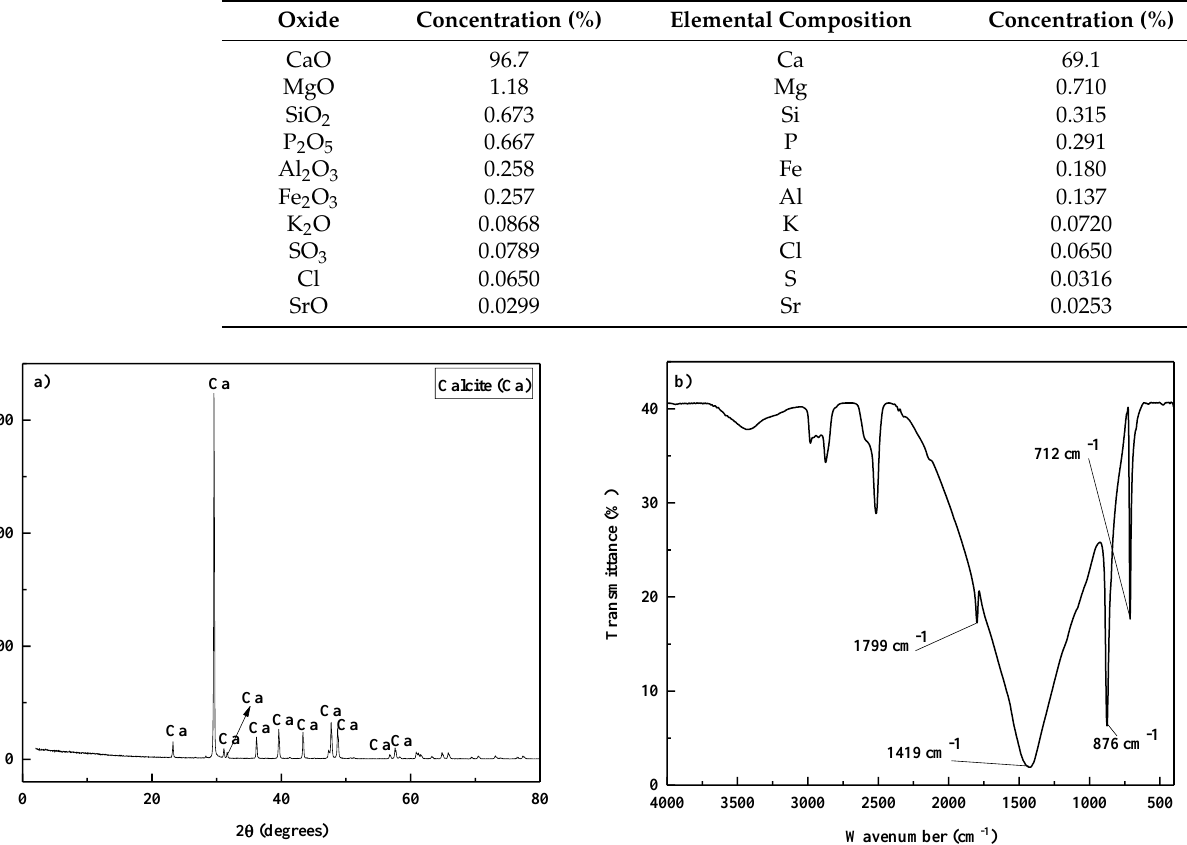
Table 3. Carbonate rock composition (XRF analysis).